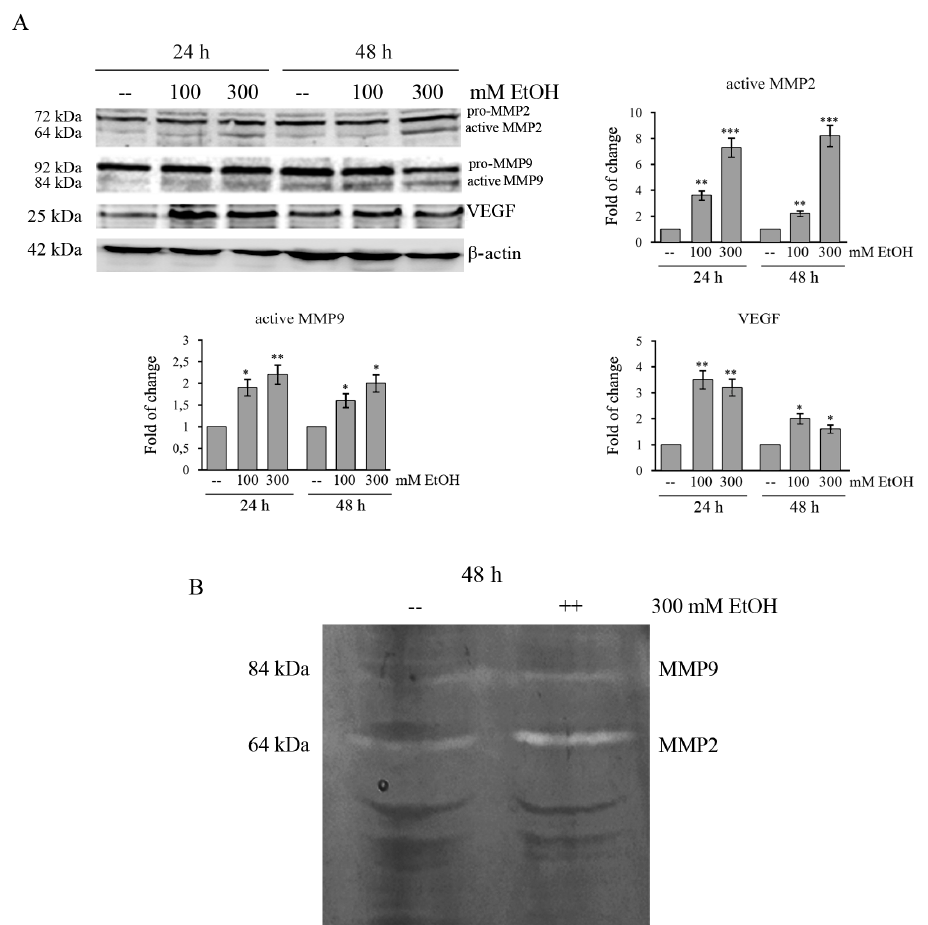
Figure 6. Ethanol increases the levels of VEGF and activates MMPs in HCT116 cells. ( A ) Western blotting analysis of MMP2, MMP9, and VEGF in HCT116 cells treated for different times with 100 or 300 mMEtOH. Quantitative estimations of the protein levels were determined by densitometry measurements of western blotting from three independent experiments after normalization with β -actin. (*) p < 0.05, (**) p < 0.01, (***) p < 0.001 compared to the untreated sample. ( B ) The activity of MMP2 and MMP9 in HCT116 cells treated with 300 mM EtOH for 48 h was examined by gelatin zymography assay. The results are representative of three independent experiments.